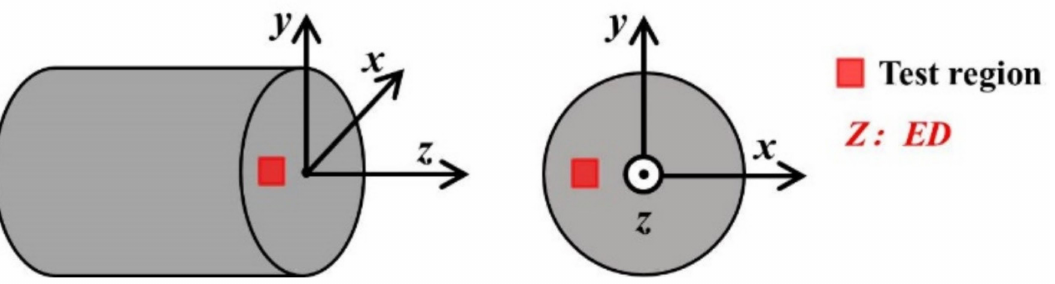
Figure 1. Schematic showing the test region of the as-extruded Mg–Gd–Dy–Zr alloys for microstruc- ture